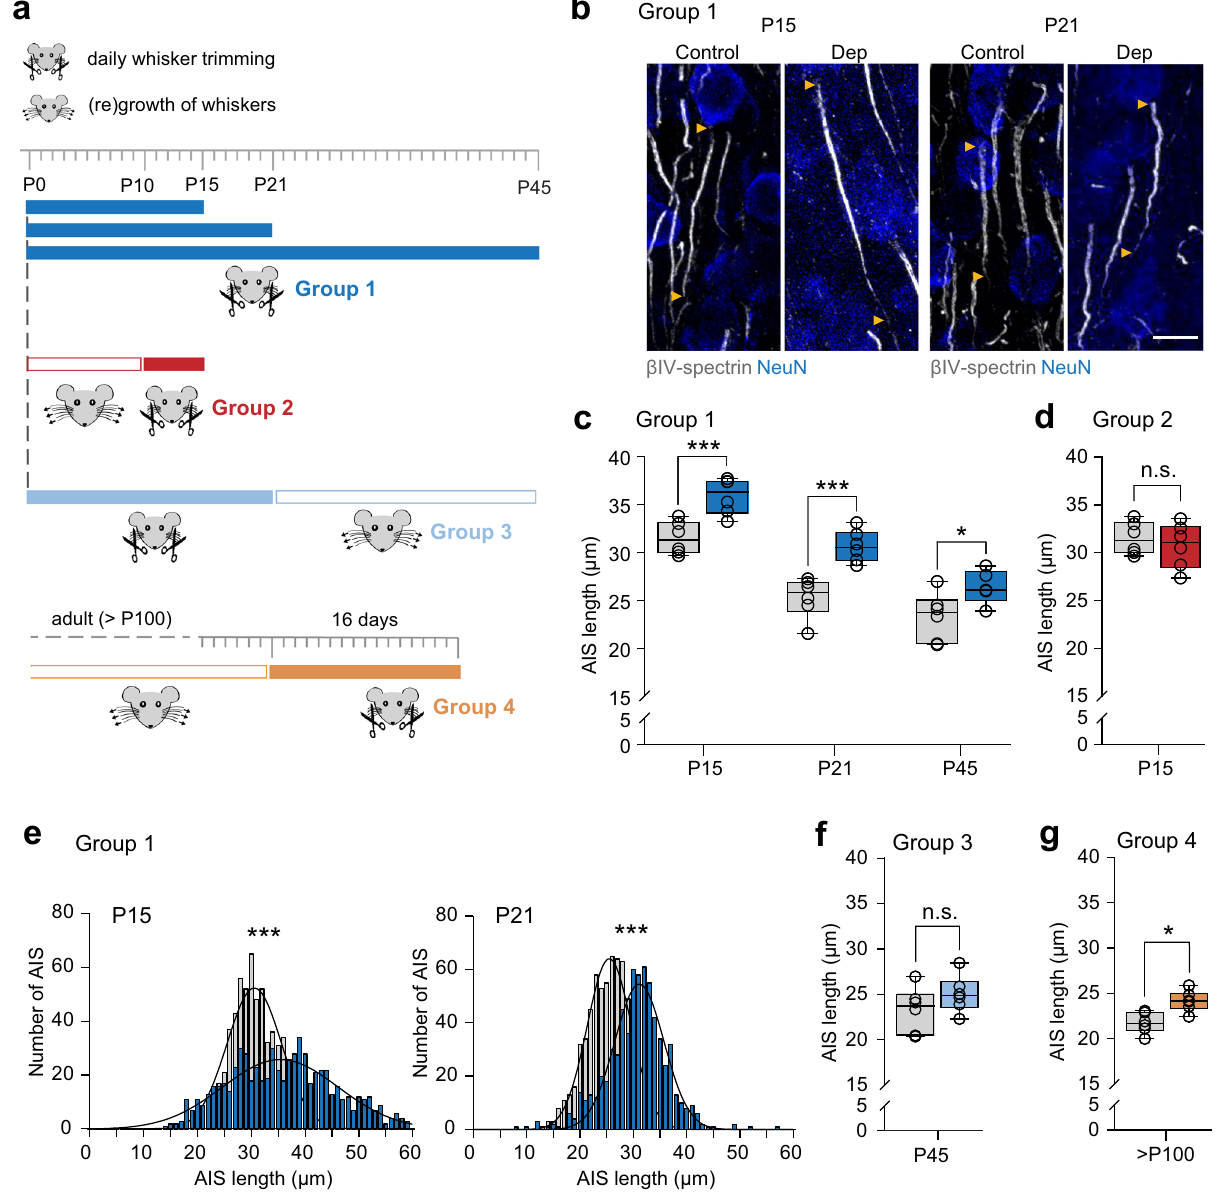
Fig. 2 Long-term sensory deprivation elongates the AIS in layer II/III of young and adult mice. a Experimental designs for whisker trimming. Group 1, daily bilateral trimming from P0 to P15, P21 or P45, respectively. Group 2, daily bilateral trimming from P10 to P15. Group 3, daily bilateral trimming until P21, followed by regrowth until P45. Group 4, daily bilateral trimming for 16 days in mice > P100. b Representative confocal images of layer II/III AIS stained for ßIV-spectrin (gray) and NeuN (blue) in control and deprived (Dep) mice. Arrowheads indicate start and end of AIS. Scale bar 10 µ m. c Population data for Group 1 (control = gray; deprived = dark blue). Deprivation leads to longer AIS (Two-way ANOVA P < 0.0001 for deprivation and development, P = 0.417 (deprivation x development), >100 AIS/animal, n = 5 biologically independent experiments for P45 Dep, n = 6 biologically independent experiments for all other groups, Sidak ’ s multiple comparison tests * P = 0.042, ** P = 0.002, *** P = 0.0002). d Population data for Group 2 (control = gray; deprived = red). Deprivation from P10 to P15 did not lead to signi fi cant length changes (unpaired two-sided t -test P = 0.53, >100 AIS/ animal, n = 6 biologically independent experiments). e Length frequency histograms for P15 and P21 (control = gray; deprived = dark blue) Dep vs Ctrl, >600 AIS per condition, Kolmogorov – Smirnov test *** P < 0.0001, median: P15: Ctrl 30.8 µ m, Dep 35.8 µ m, P21 Ctrl 25.6 µ m, Dep 31.0 µ m). f Population data for Group 3 (deprived = light blue; age-matched controls = gray) at P45. Upon whisker regrowth, AIS length returned to control levels (unpaired two- sided t -test P = 0.22, >100 AIS/animal, n = 6 biologically independent experiments). g Population data for Group 4 (adult > P100; deprived = orange; age- matched controls = gray). Deprived animals showed signi fi cantly longer AIS after two weeks of whisker trimming (unpaired two-sided t -test ** P = 0.0046, >100 AIS/animal, n = 6 biologically independent experiments). Boxplots: median with 25 – 75% interval, error bars show minimum to maximum